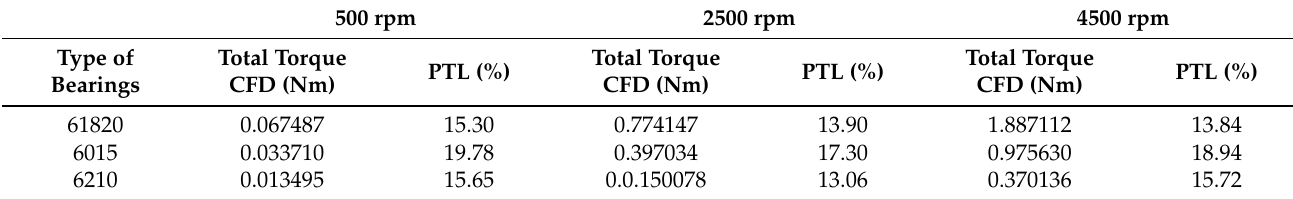
Table 5. Results of transient CFD simulations for hubs in